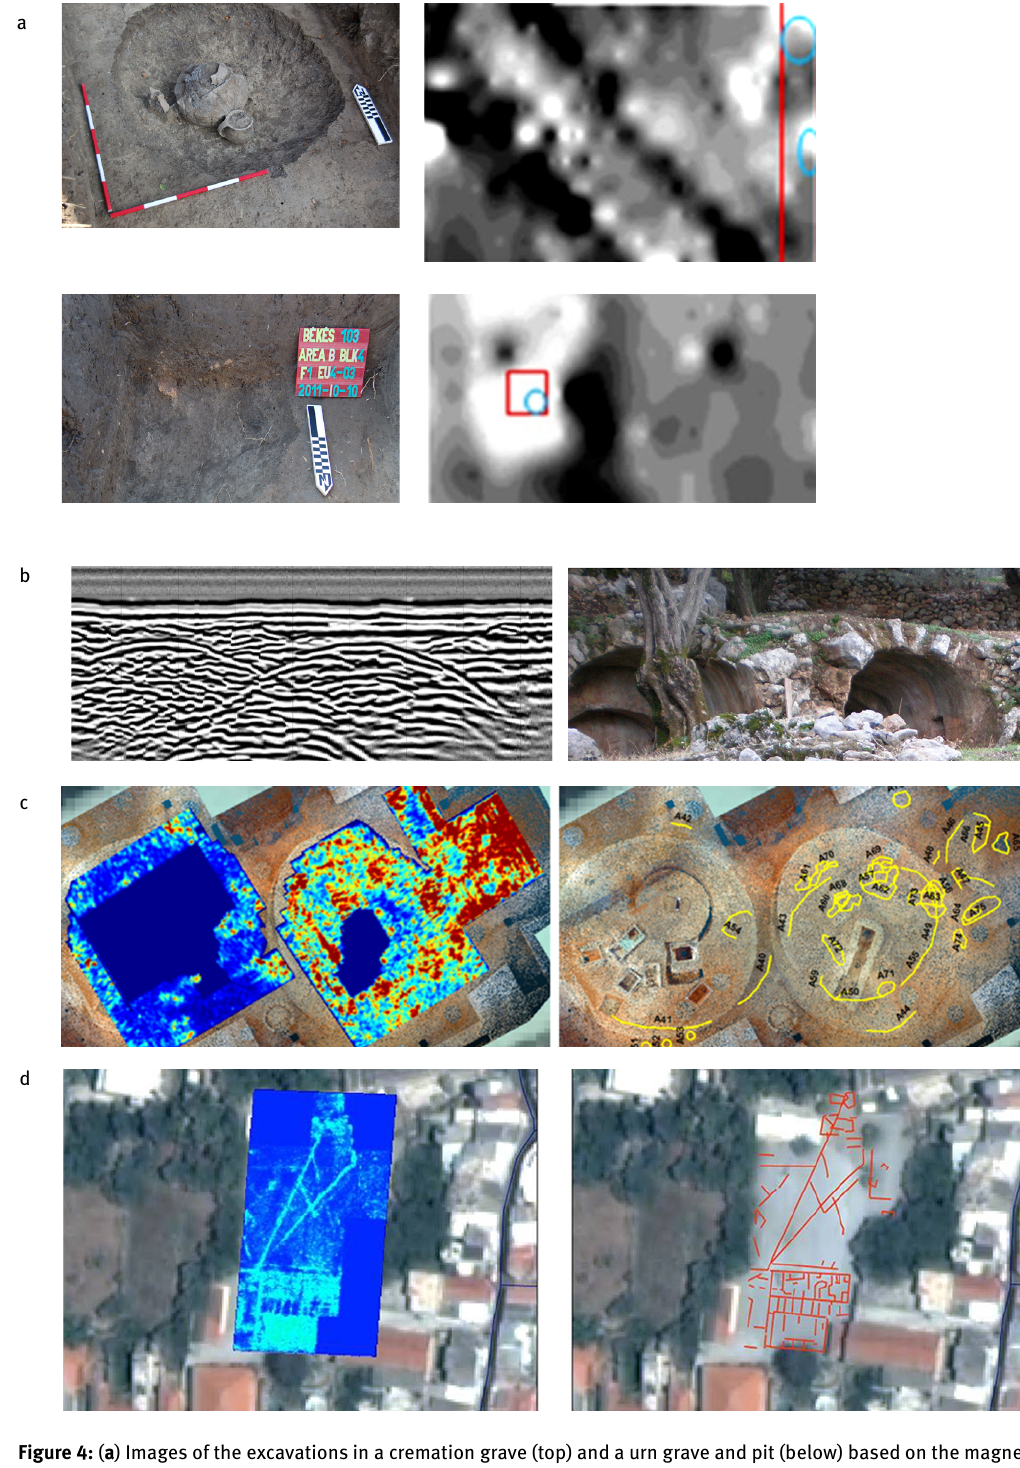
Figure 4: ( a ) Images of the excavations in a cremation grave (top) and a urn grave and pit (below) based on the magnetic survey carried out at Békés Koldus-Zug site in Hungary (Sarris et al., 20016a). ( b ) GPR reflection signals produced by under- ground rock cut Roman tombs from Axos, central Crete (Sarris & Papadopoulos, 2013). ( c ) Results of the GPR survey that was carried out within the area covered by tumuli I, II and III at Vranas, Marathon: left image shows the GPR depth slice at 1.40–1.50m below the surface and right image shows the diagrammatic interpretation of the suggested GPR reflectors (Sarris et al., 2016b). ( d ) Rectification and overlay of the 70cm GPR depth slice on the Quickbird satellite image covering the Mikra- siaton Square at the centre of Rethymno, Crete (left image). The interpretation of the GPR reflectors indicated the architectural relics of the Venetian period Saint Frangiskos monastery (Papadopoulos et